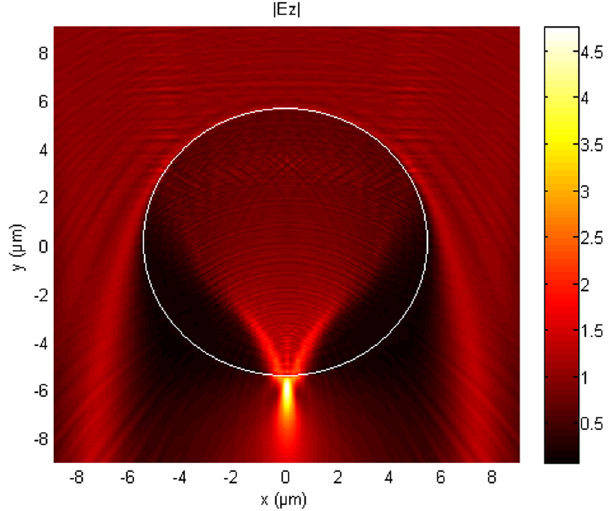
Figure 1. The formation of a photonic nanojet resulting from unitary (1 V/m) plane waves ( λ from 400 nm to 1000 nm) illuminating (from the top) an 11 µ m microsphere (n = 1.68) using 2D FEM (TE wave case) electric field simulation (absolute values |E z